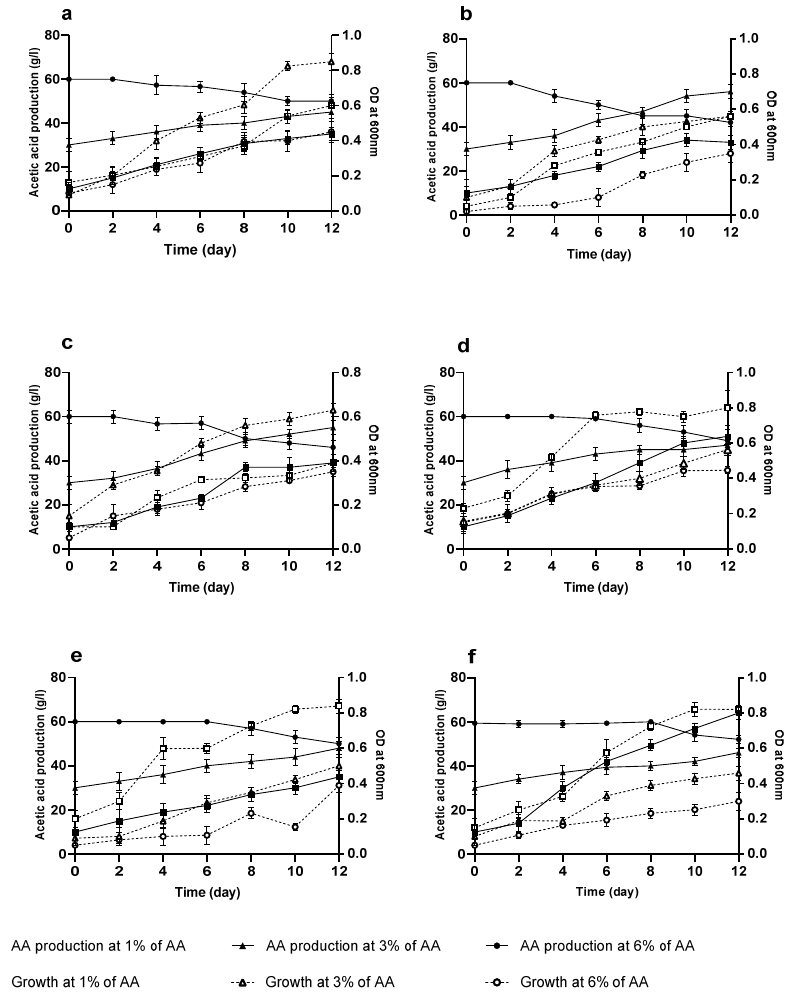
Figure 5. Effect of acetic acid on the production and growth of the six isolated strains. FAGD1 ( a ). FAGD10 ( b ). FAGD18 ( c ). GCM2 ( d ). GCM4 ( e ). GCM15 ( f ).